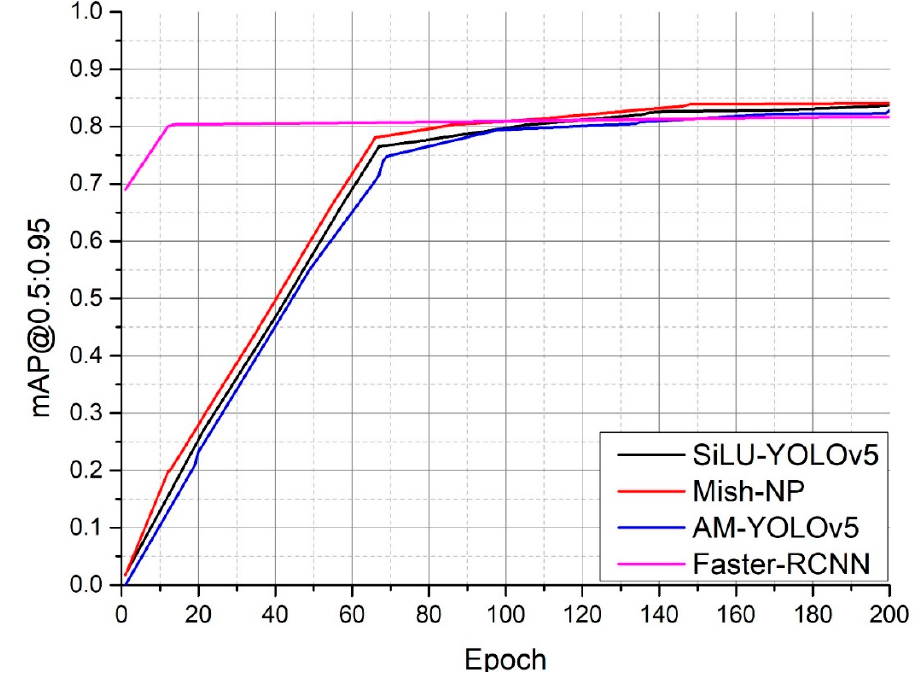
Figure 11. Comparison of the average of mAPs from IOU = 0.5 to IOU = 0.95 for algorithms.